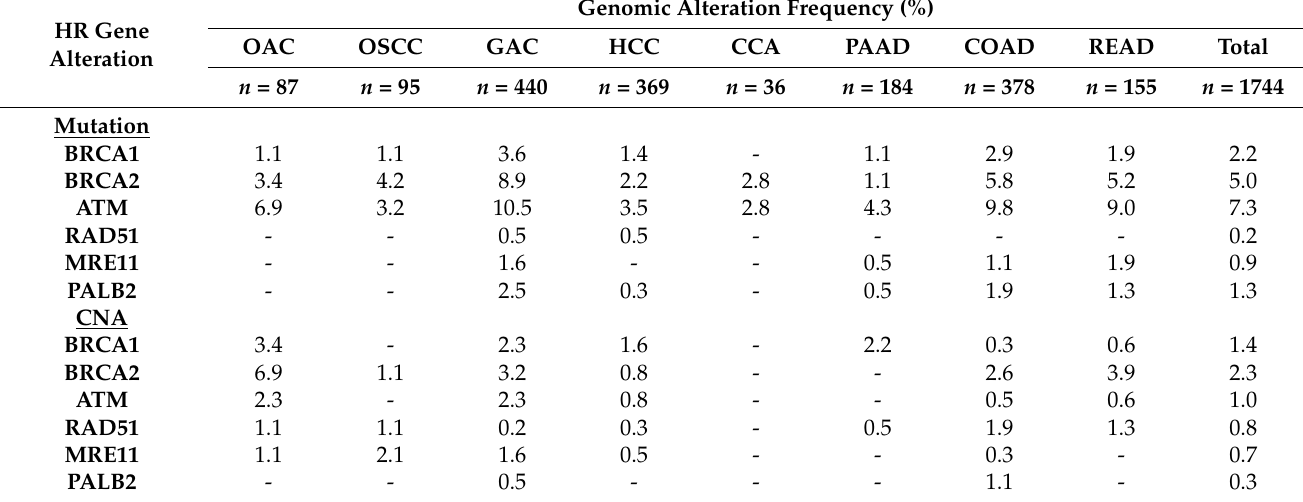
Table 3. Frequency of HR Mutations and Copy Number Alterations Across the Gastrointestinal Cancer Cohorts. HR, homologous recombination—represents zero mutations/CNA; n , total number of patients. Frequency (%) was calculated as the percentage of patients who had a gene mutation/CNA from the total number of patients in the cohort of the same cancer